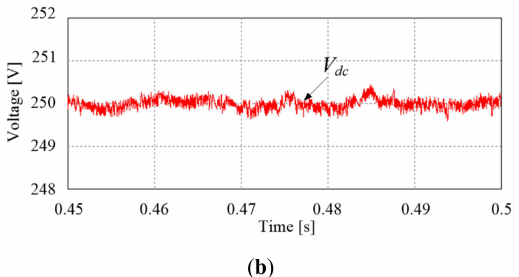
Figure 8. Simulation results of output voltage obtained from ( a ) the conventional algorithm and ( b ) the proposed algorithm.